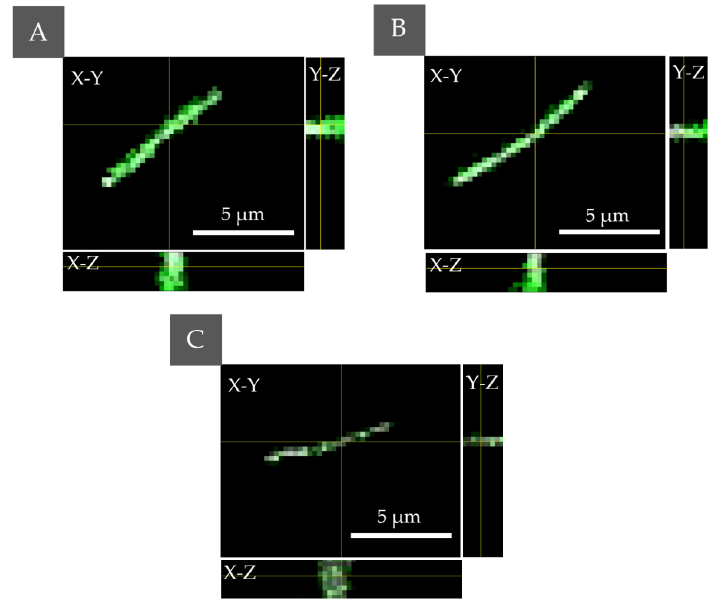
Figure 2. The PS localization performed by fluorescence confocal microscopy for E. coli with accumulated ( A ) Ce6 + Pheo, ( B ) Ce6, ( C ) Pheo—the combined fluorescence–DIC images with axial cross sections: X–Z/Y–Z (the yellow lines indicate the cross section through a cell).